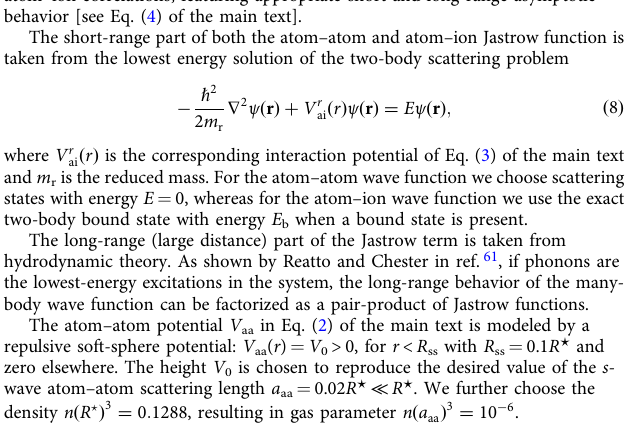
Fig. 1 of the main text: weak-coupling Bose polaron (WCP), MBBS, and strong- coupling Bose polaron (SCP). In Table 1 we list those values in units of R ⋆ and E ⋆ . Trial wave functions for the Monte Carlo simulations . The trial wave functions are written as a pair product of Jastrow functions for both atom – atom and atom – ion correlations, featuring appropriate short and long-range asymptotic behavior [see Eq. (4) of the main text].